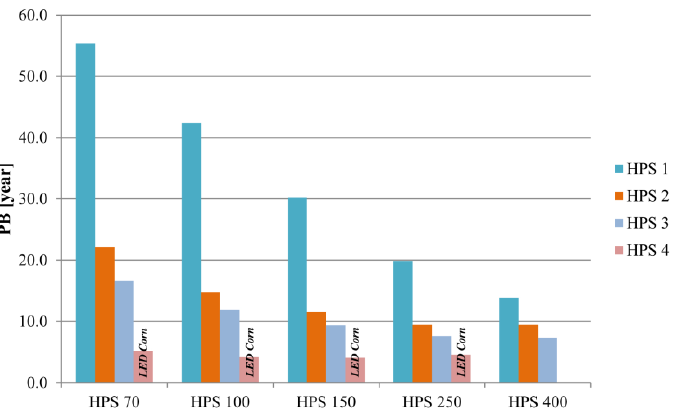
Figure 7. Payback period of proposed energy efficiency measures for HPS lamps.